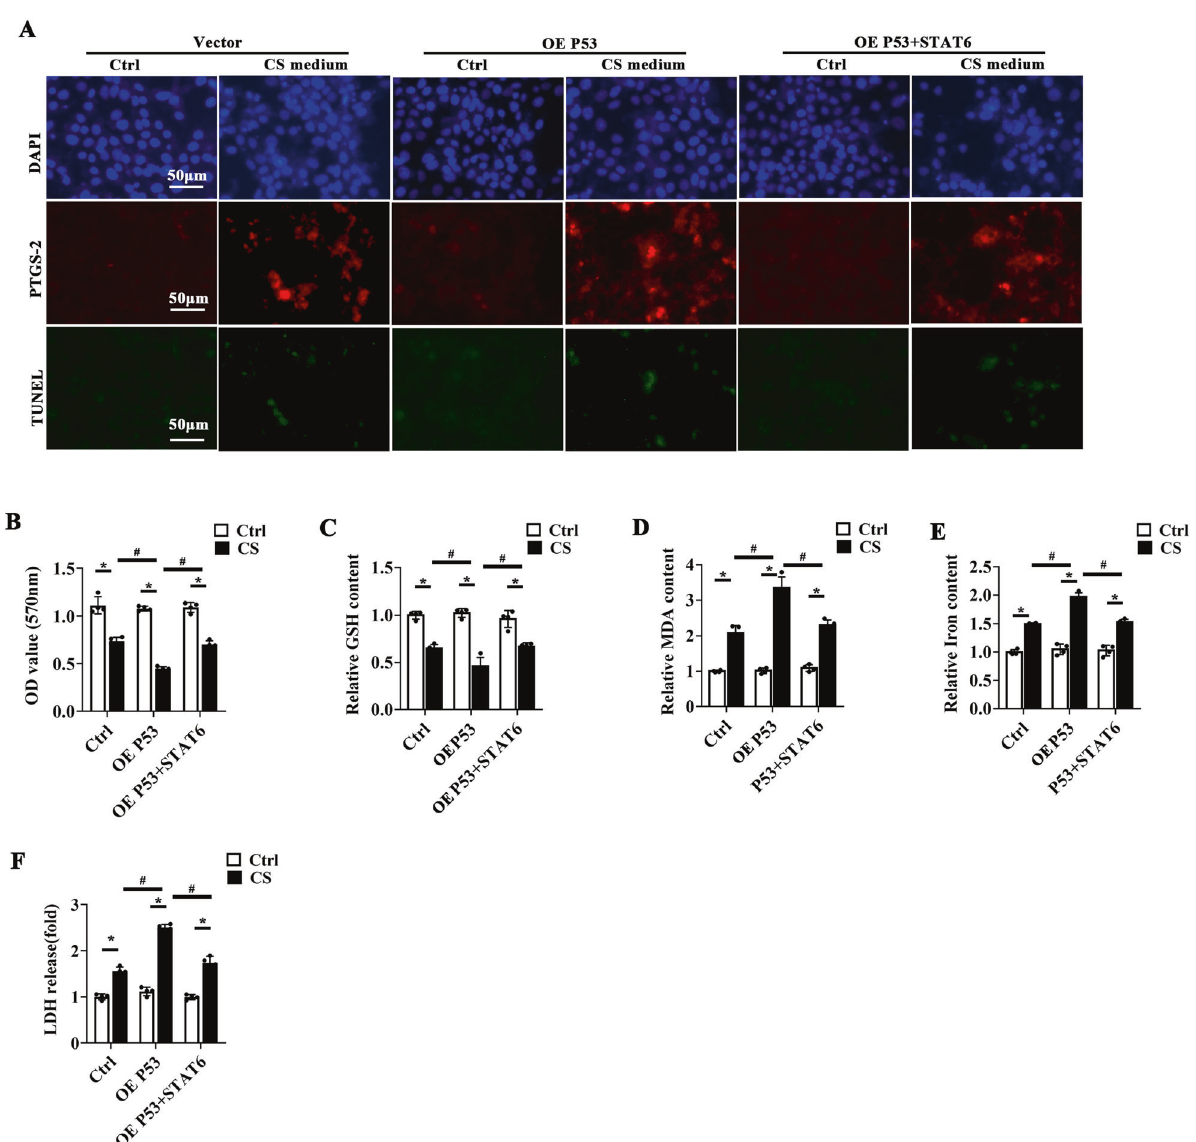
Fig. 5 STAT6 combats P53 overexpression induced cell ferroptosis. HBE cells were transfected with empty vector or plasmids for P53 and/or STAT6 overexpression. Then cells were treated with Ctrl or CS medium for another 24 h. A Representative images of PTGS-2 immuno fl uorescence and TUNEL staining of cells from the indicated group. The cell viability B , GSH C , MDA D , Iron E content and LDH release ( F ) of indicated group were measured by corresponding kit. The data were presented as means ± SD ( n = 4, * p < 0.05, Ctrl vs . CS; # p < 0.05, P53 + CS vs . CS or P53 + STAT6 +